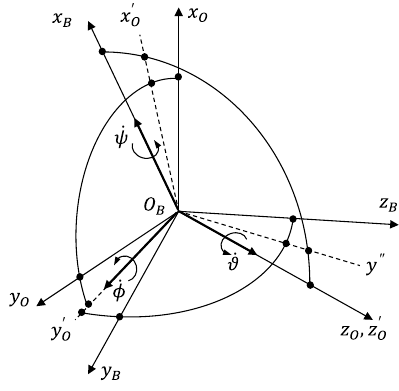
Figure 6: Orientation of BRF with respect